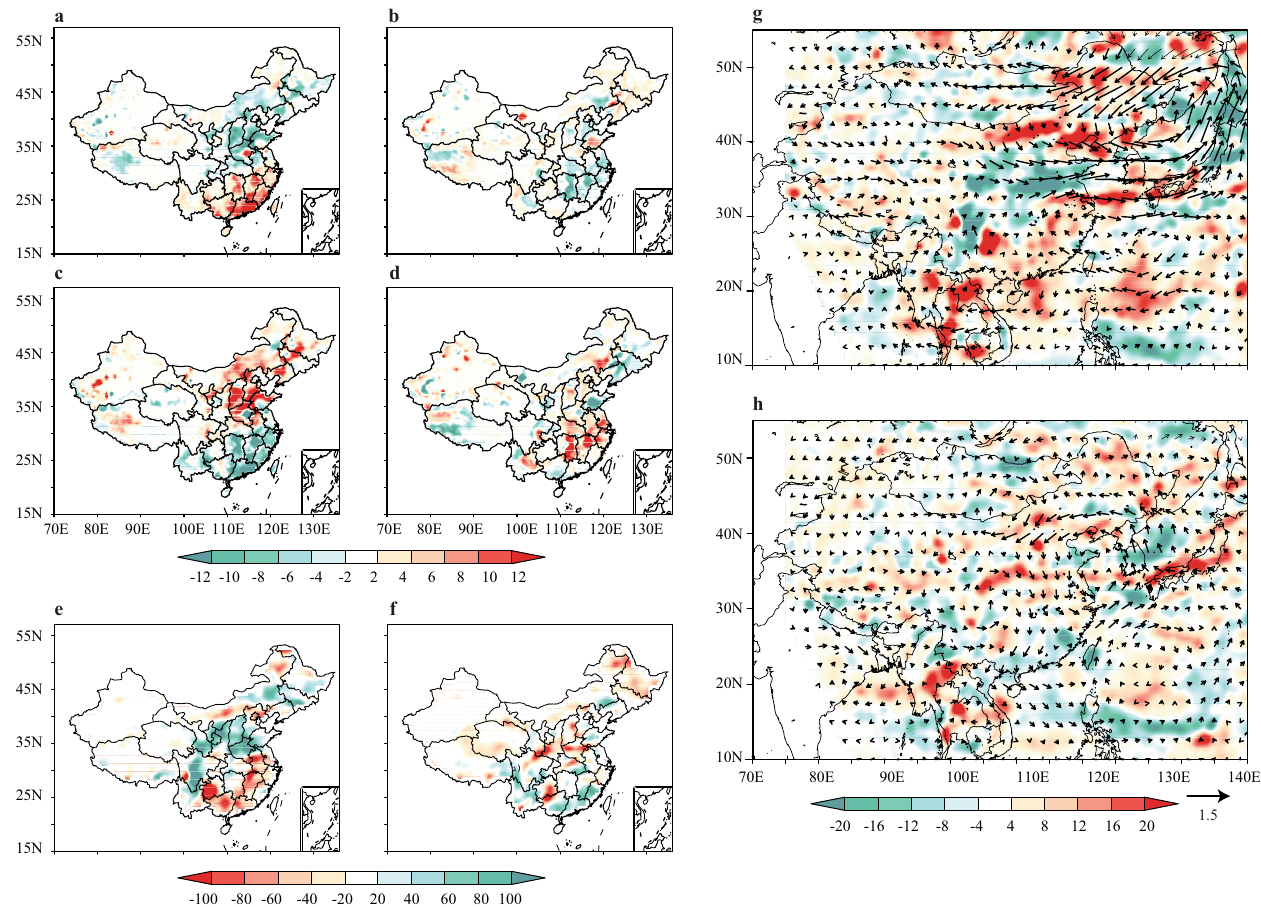
Fig. 5 The composite difference of surface energy fl uxes, precipitation, and atmospheric variables for SM ECV and SM CLIM simulations. The composite difference of a , b SH, c , d LH fl uxes (unit: W m − 2 ), e , f precipitation, and g , h 500 hPa wind (vectors) and vertical velocity (shaded) (unit: ω *10 − 2 Pa s − 1 ) for ( a , c , e , g ) SMI wet and ( b , d , f , h ) SMI dry . The composite differences are calculated by subtracting the SM CLIM composites from SM ECV